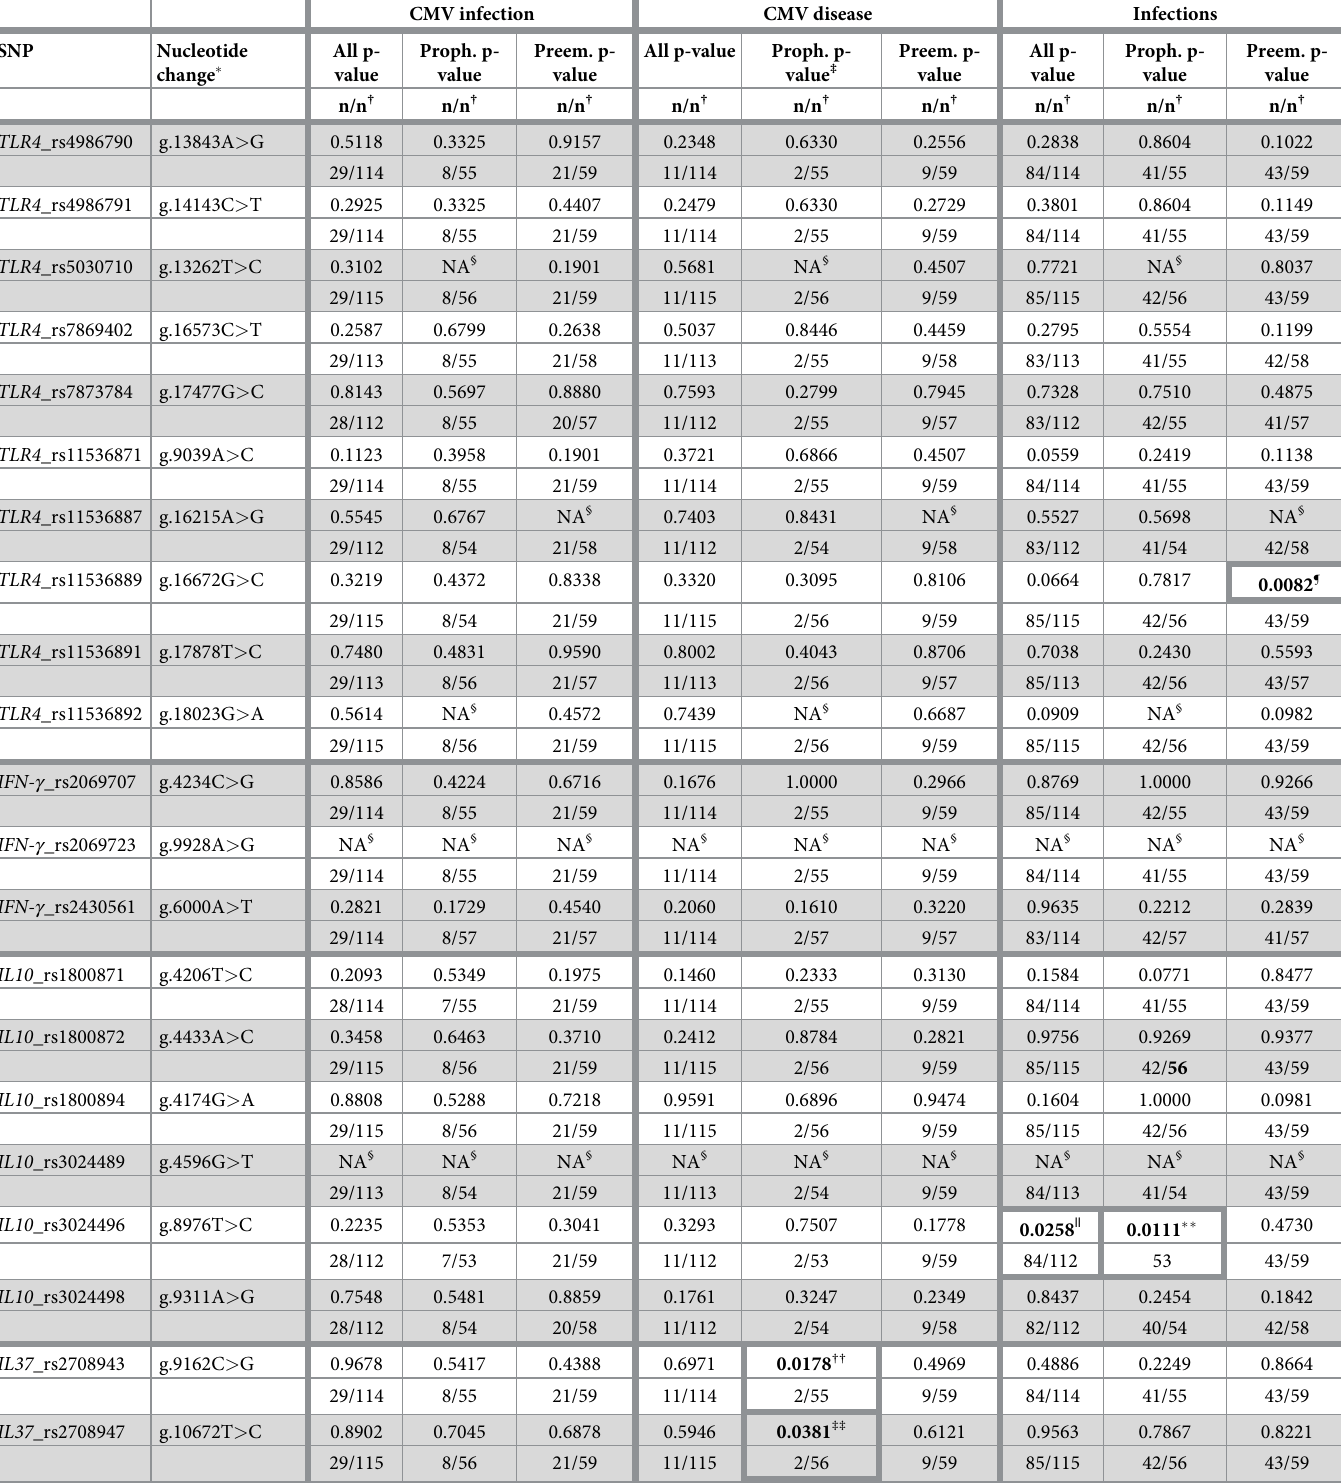
Table 2. Statistical analysis of the association between genetic variants and the clinical events CMV infection, CMV disease and infections in all patients, and in the prophylaxis and preemptive treatment